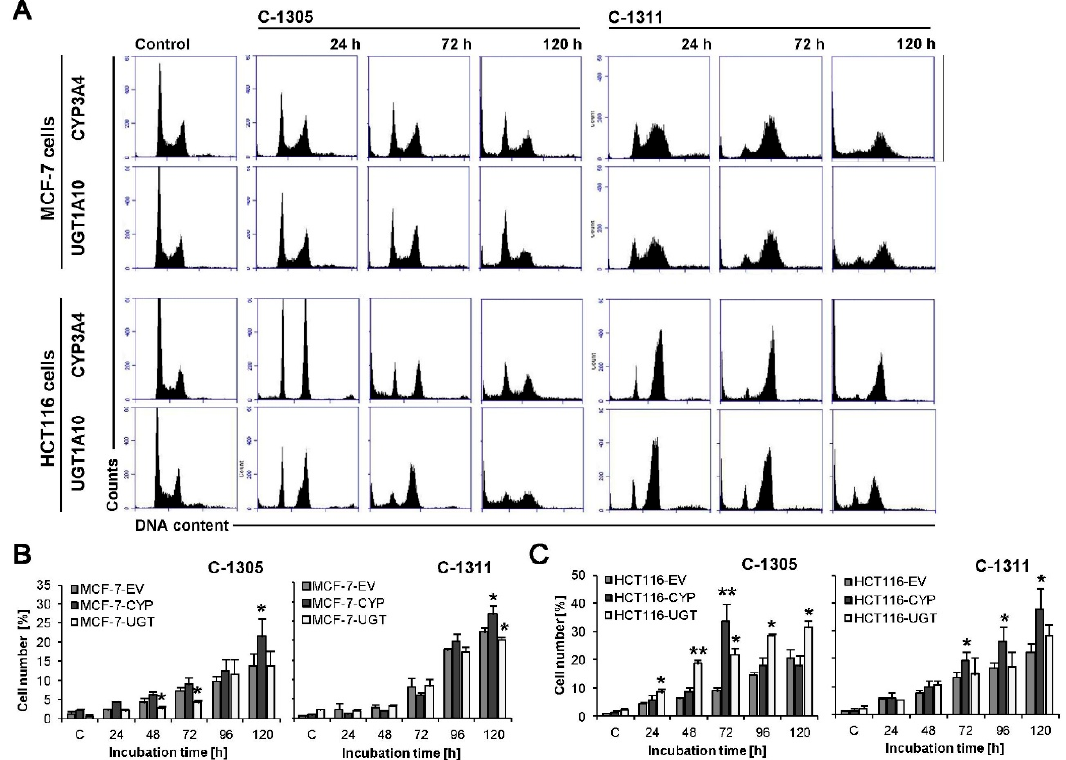
Figure 7. Cell cycle distribution of MCF-7-CYP3A4, MCF-7-UGT1A10, HCT116-CYP3A4 and HCT116-UGT1A10 cells. Cells were untreated (control) or treated with C-1305 or C-1311 (IC 80 for MCF-7 cells, IC 90 for HCT116) for the times indicated and subjected to propidium iodide staining and flow cytometry as described in Materials and Methods. ( A ) Histograms show number of cells ( y -axis) versus DNA content ( x -axis) and are representative of at least three experiments for each condition. ( B , C ) Bar graphs show data quantitation with percentage of cells with less than 2N DNA (sub-G1 fraction): three types of MCF-7 ( B ) and HCT116 ( C ) cells treated with C-1305 or C-1311. Results are expressed as mean ± SEM ( n ≥ 3). Significant differences in cell percentages between control, stably transfected with EV cells and UGT1A10- or CYP3A4-transfected are indicated as follows: * p ≤ 0.05; ** p ≤ 0.001.